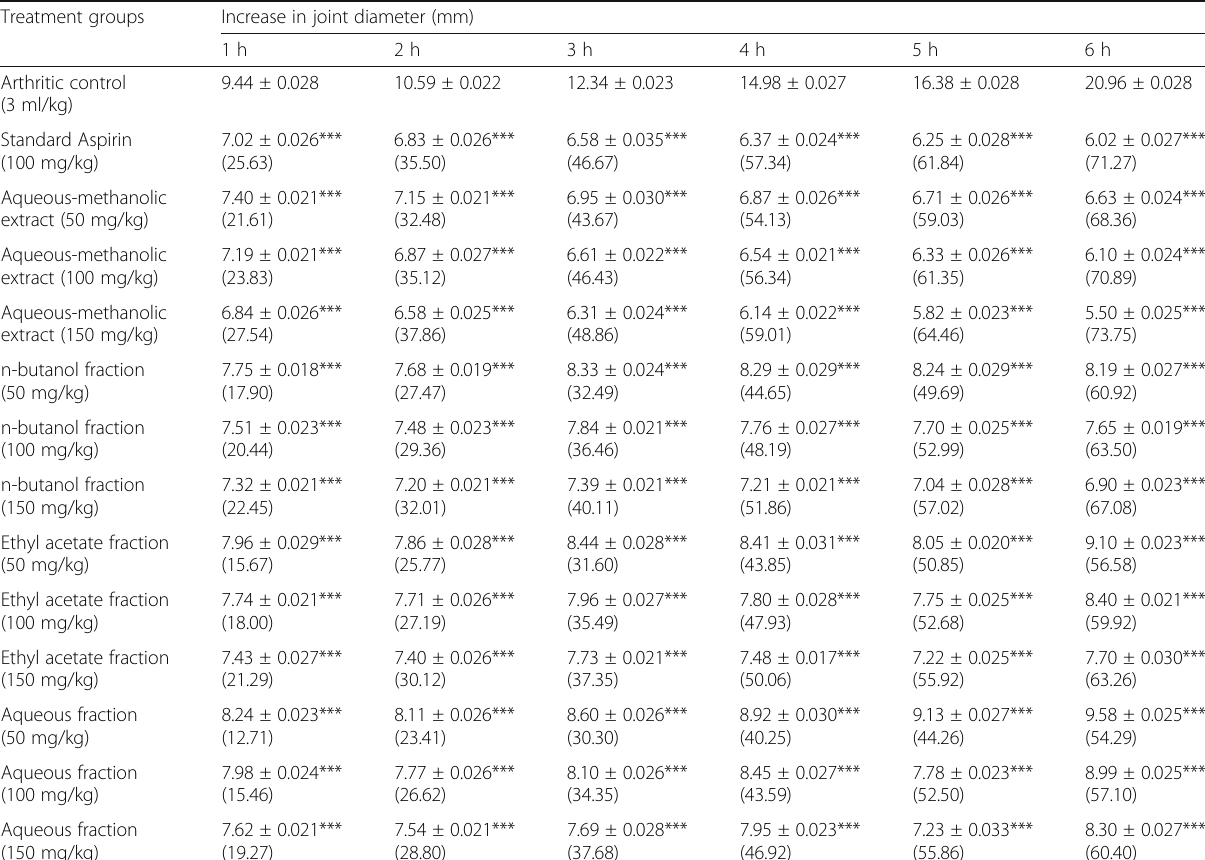
Table 1 Effect of B.orthobotrys on turpentine oil induced joint edema in rats ( n = 5, Mean ± SEM) Treatment